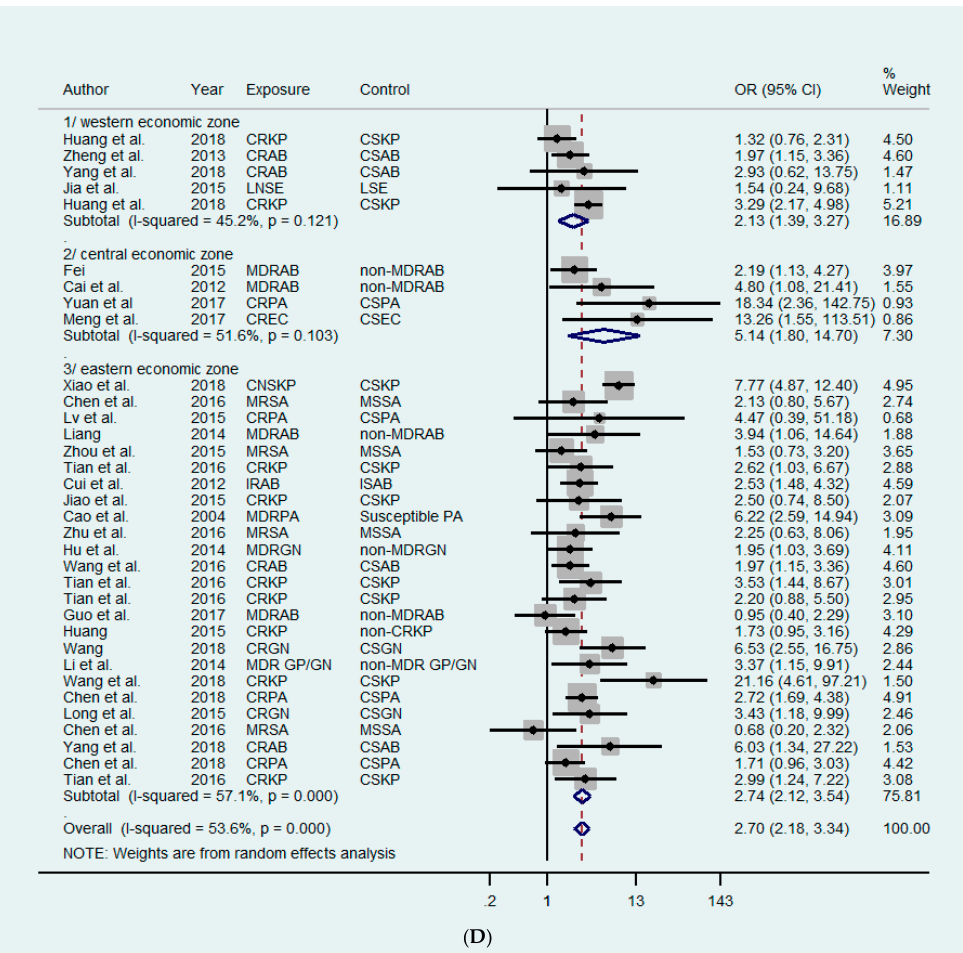
Figure 3. Forest plot of impact of antibiotic resistance on mortality and sub-group analyses. ( A ) Forest plot of overall mortality of antibiotic resistance compared to those with susceptibility. ( B ) Forest plot of overall mortality of antibiotic resistance compared to those without infection. ( C ) Forest plot of overall mortality of antibiotic resistance compared to those with susceptibility based on bacteria. ( D ) Forest plot of overall mortality of antibiotic resistance compared to those with susceptibility based on economic zones (eastern economic zone, central economic zone, and western economic zone). OR: